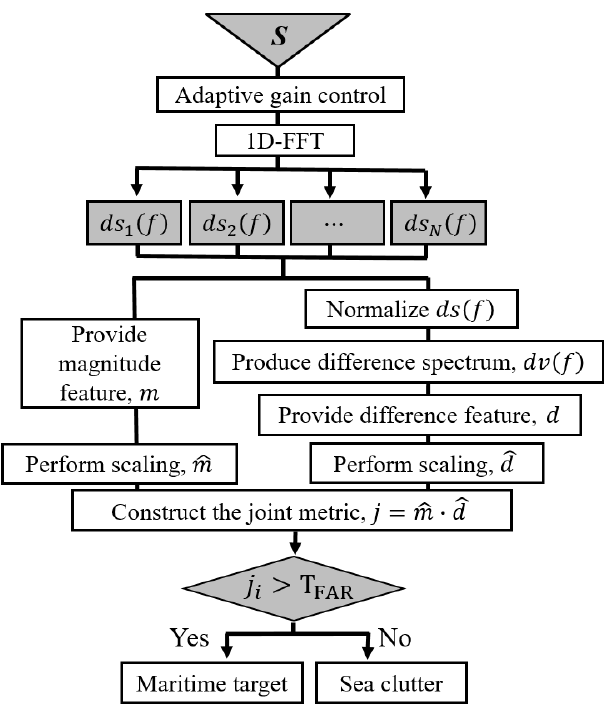
Figure 1. Flowchart illustrating steps of the proposed maritime target